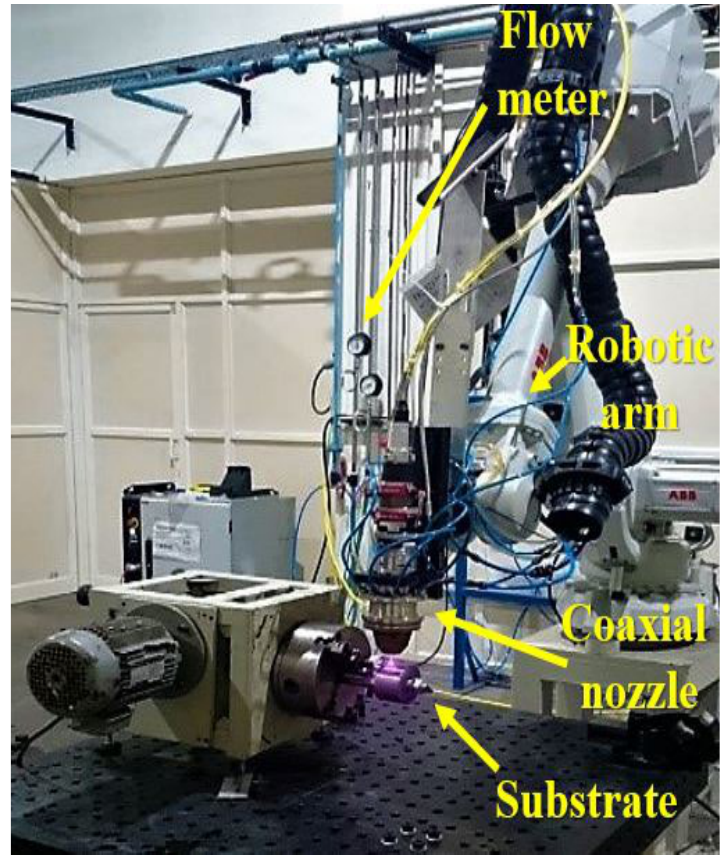
Figure 1. Setup of the laser cladding unit.